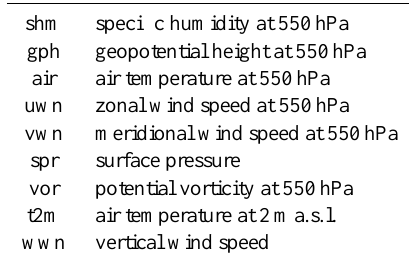
Table 3. List of predictors (and their abbreviations) assessed in Sect.